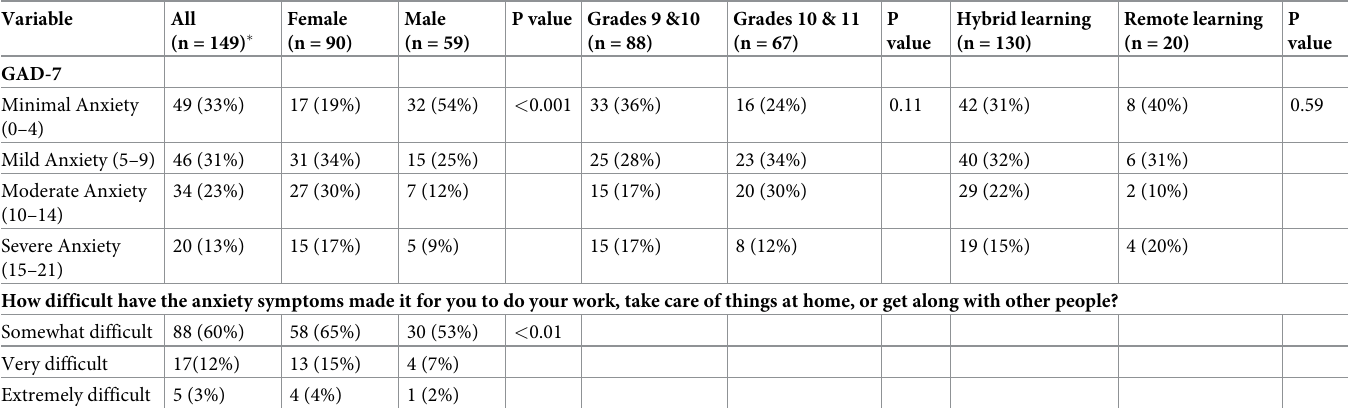
Table 2. Severity of anxiety assessed by GAD-7 stratified by gender, grade and learning